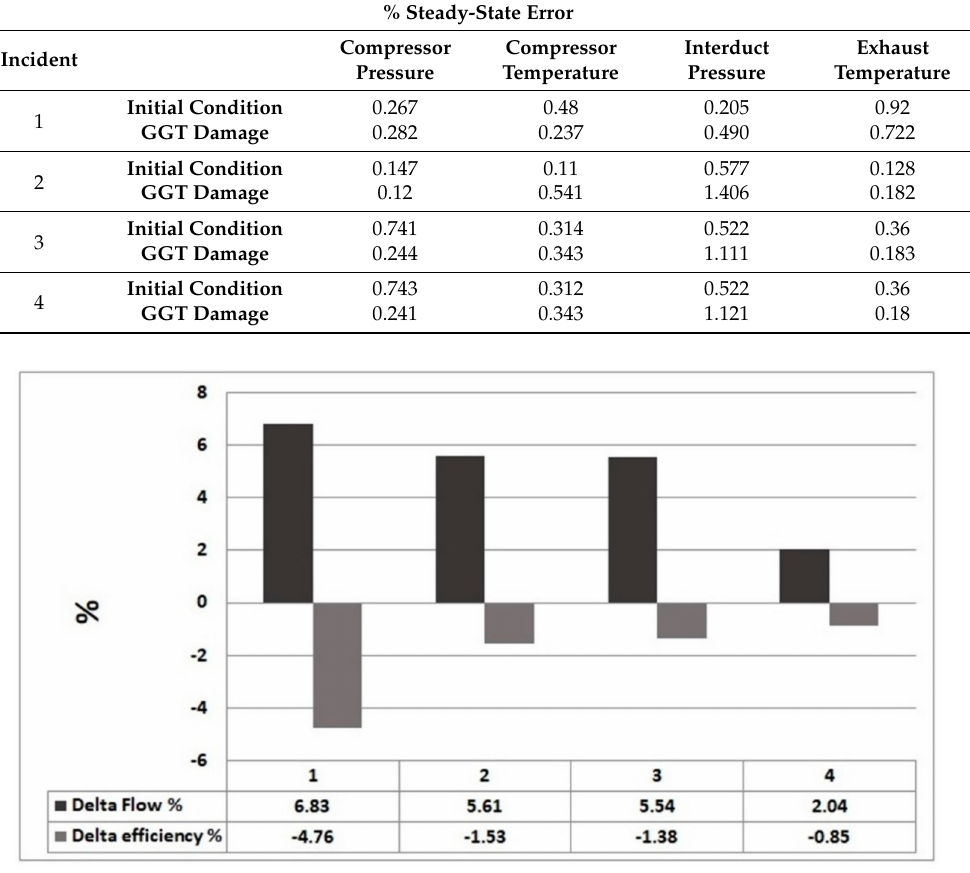
Figure 26. % Delta for flow capacity and efficiency in